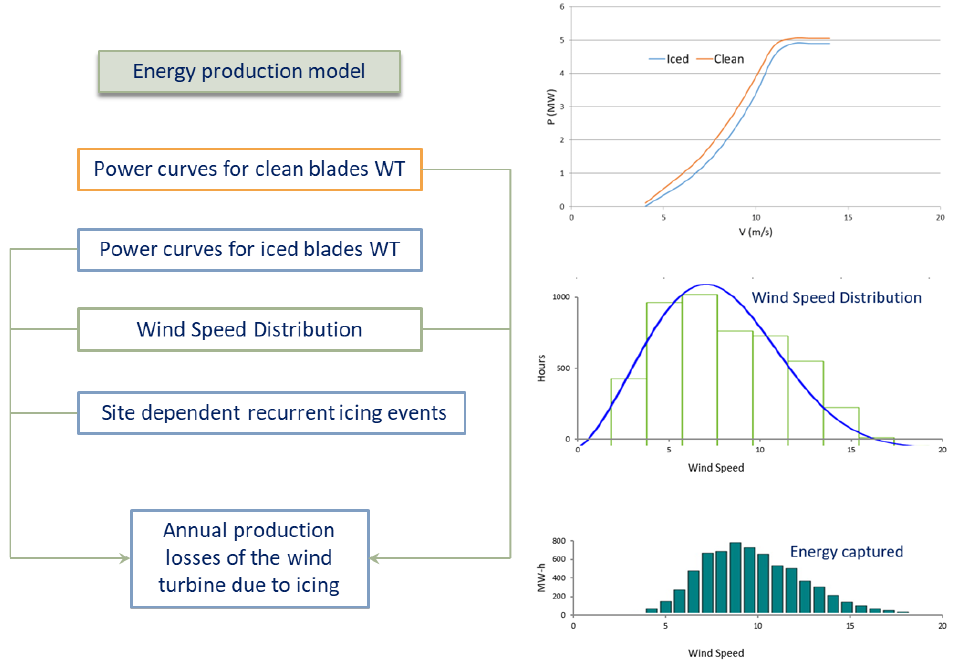
Figure 9. Estimation of annual production losses related to icing. @Fahed Martini.